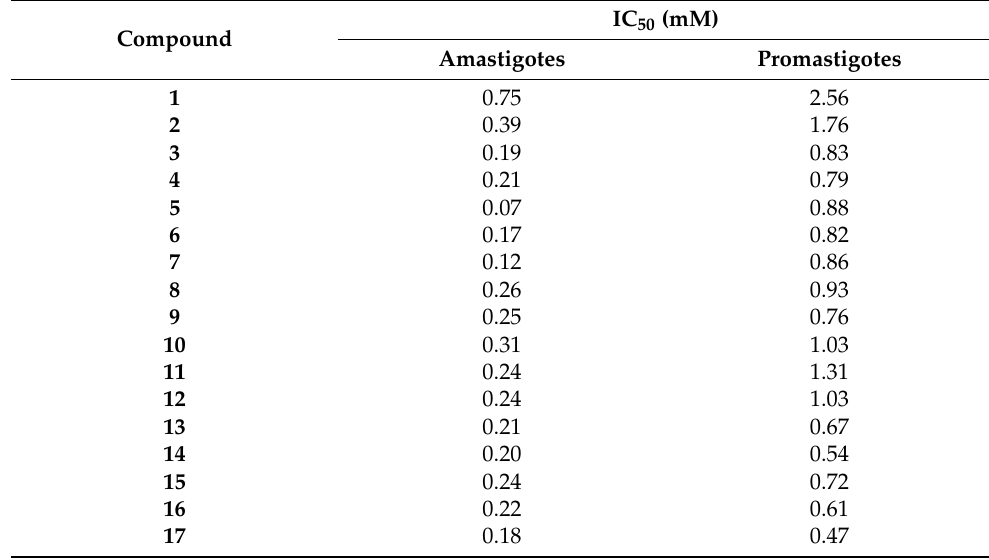
Table 1. Antileishmanial activity and cytotoxicity of piperoyl–amino acid conjugates. ( 1 ) Piperine;